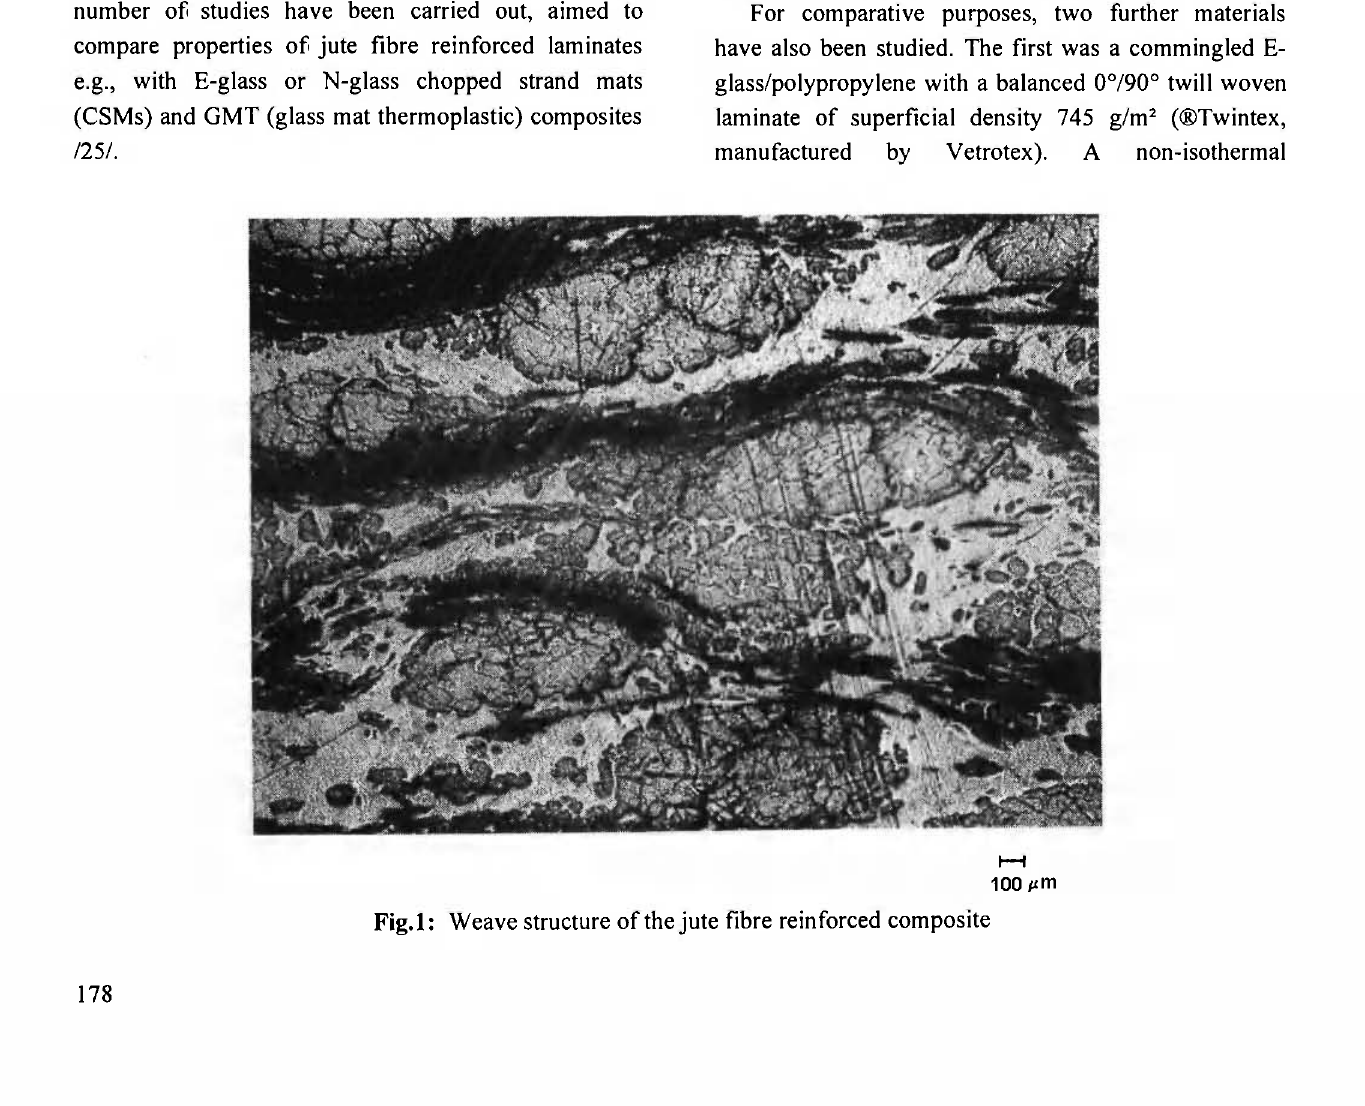
Fig.l : Weave structure of the jute fibre reinforced